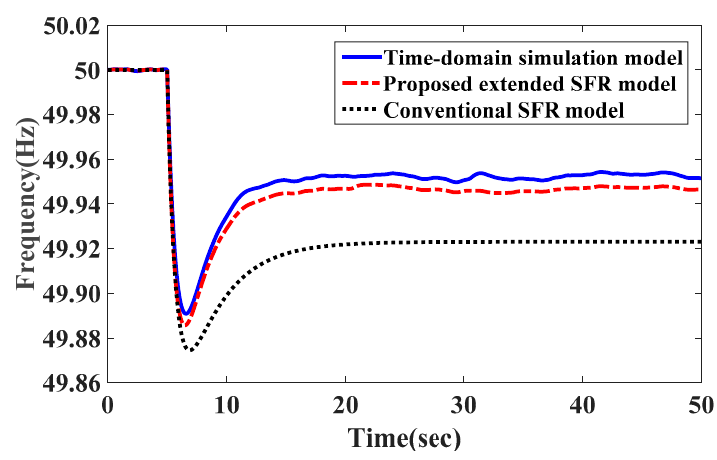
Figure 10. Comparison of SFR model with time simulation model of test system.